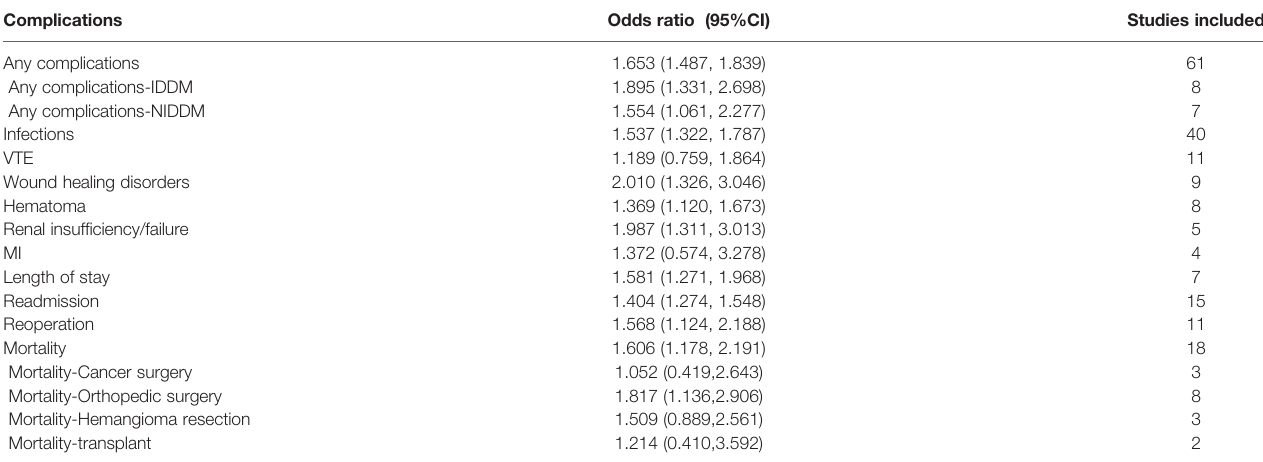
TABLE 2 | Outcomes.